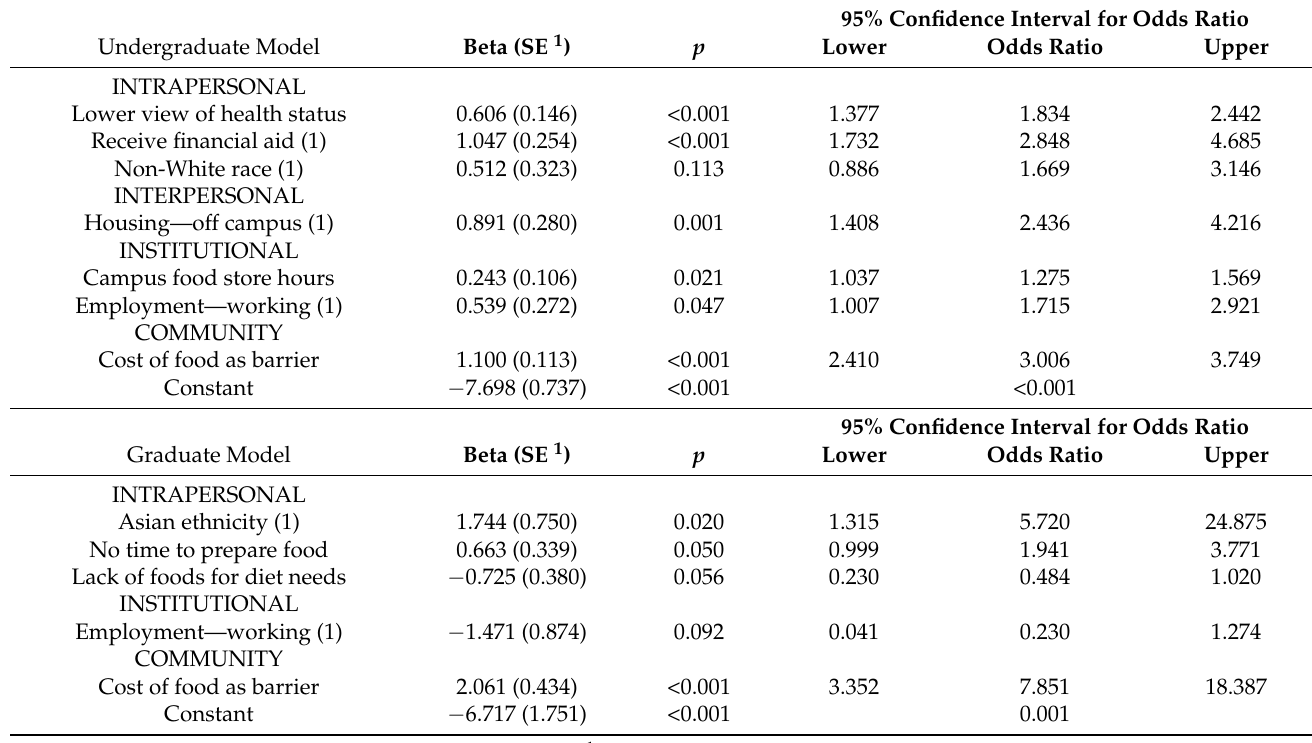
Table 5. Logistic regression model of predictors of food insecurity among midwest university undergraduate and gradu- ate students.